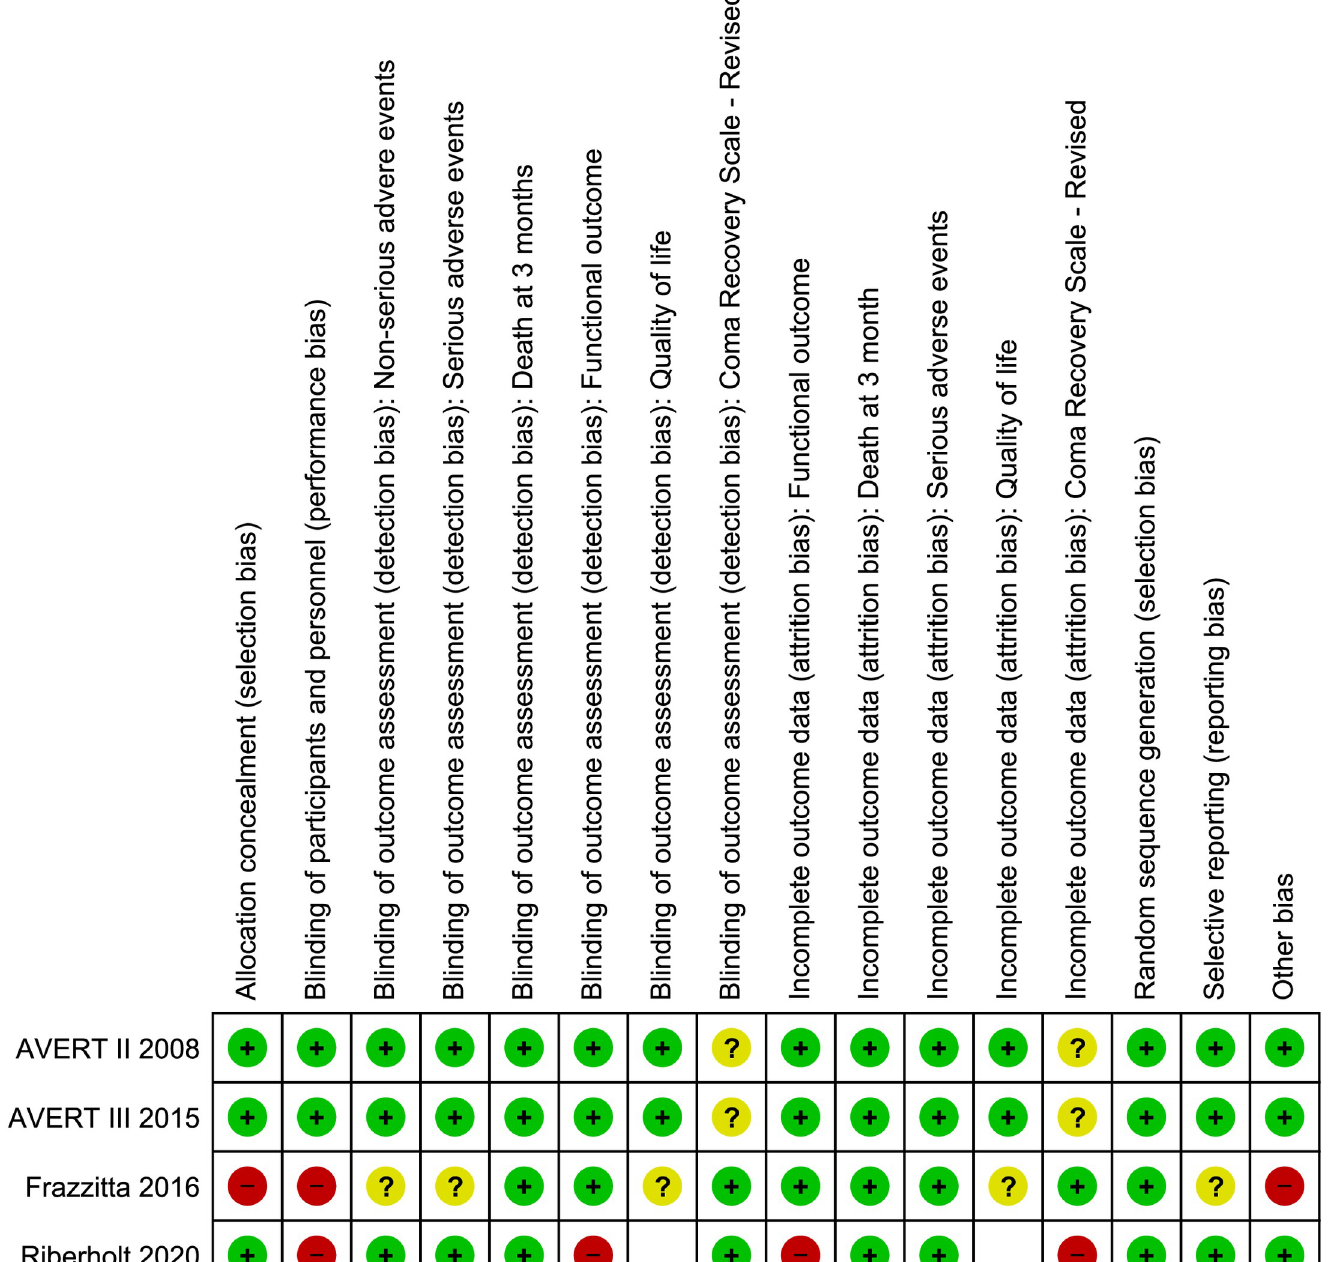
PLOS ONE | https://doi.org/10.1371/journal.pone.0237136 August 13,